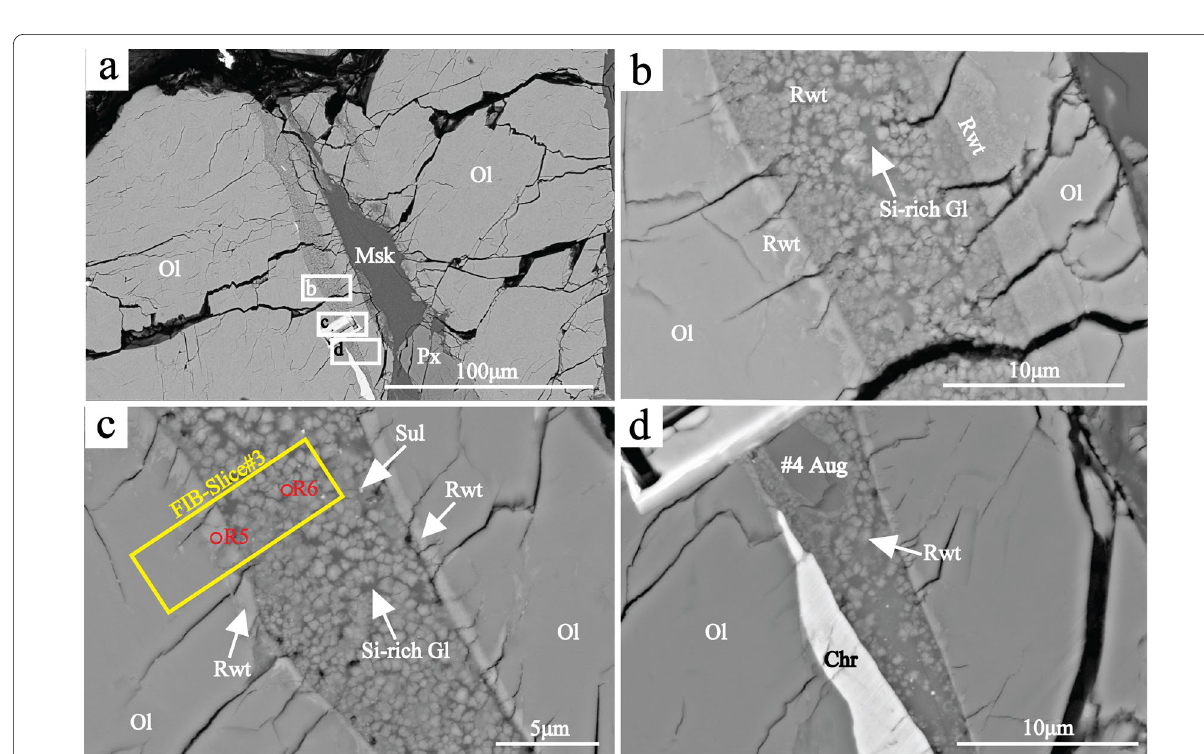
Fig. 7 BSE images of the granular ringwoodite. a A shock-induced melt vein (~ 20 μm in width), cutting through olivine. The regions marked by white boxes “b”, “c”, and “d” are shown in b, c, d , respectively. b Submicron-sized ringwoodite grains embedded in a Si-rich glass (Gl). Note larger ringwoodite grains in the center than those adjacent to the rims. The olivine walls in contact with the vein have been transformed into ringwoodite too. c Similar texture of b . The yellow box shows the position of FIB-slice #3. Two Raman analyses are marked as R5 and R6. d Ringwoodite microlite clusters and an augite in the melt vein. Raman spectrum #4 confirms the augite. Chr chromite; others are the same as